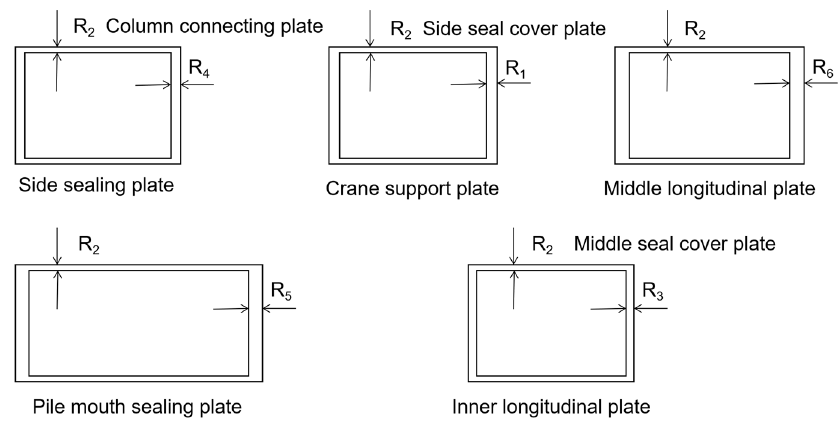
Figure 5. Section size of large structure.